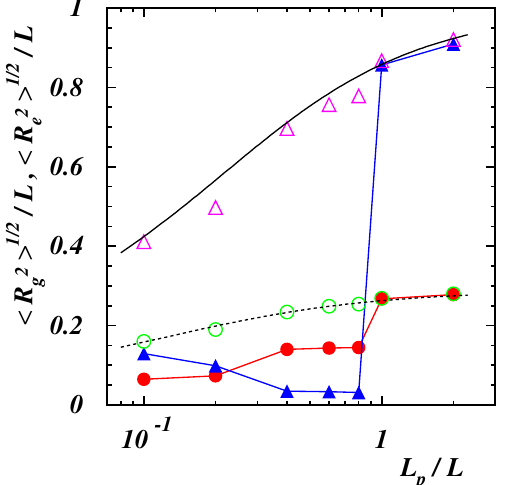
Figure 2. Root -mean-square end-to-end distance R e of a polymer in absence of an external force for (cid:101) / ( k B T ) = 0.25 (purple open triangles), 2 (blue filled triangles), and gyration radius R g for (cid:101) / ( k B T ) = 0.25 (green open circles), 2 (red filled circles). The full and dashed black lines correspond